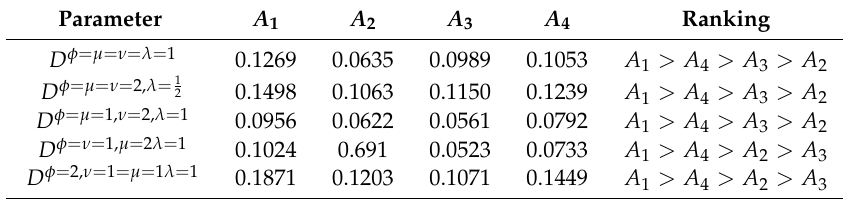
Table 2. Results shown by Equation (10) corresponding to different